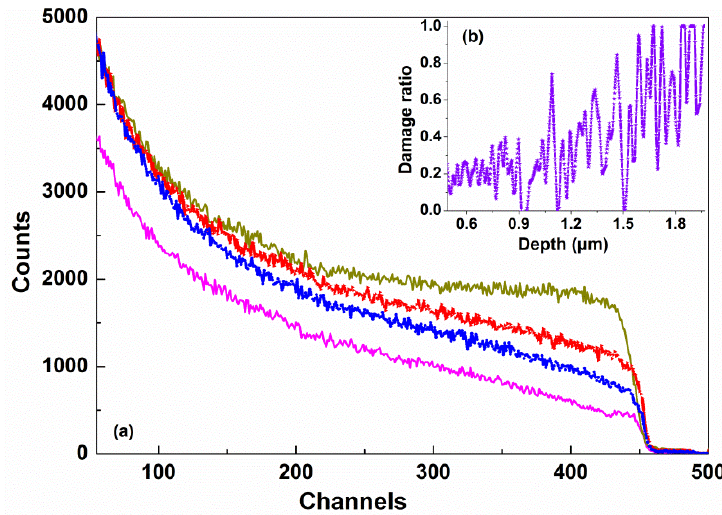
Figure 5. ( a ) Aligned and random spectra for yttria-stabilized zirconia crystals before and after oxygen irradiation. ( b ) The disorder profile near surface region were extracted from the Rutherford backscattering/channeling spectrum.